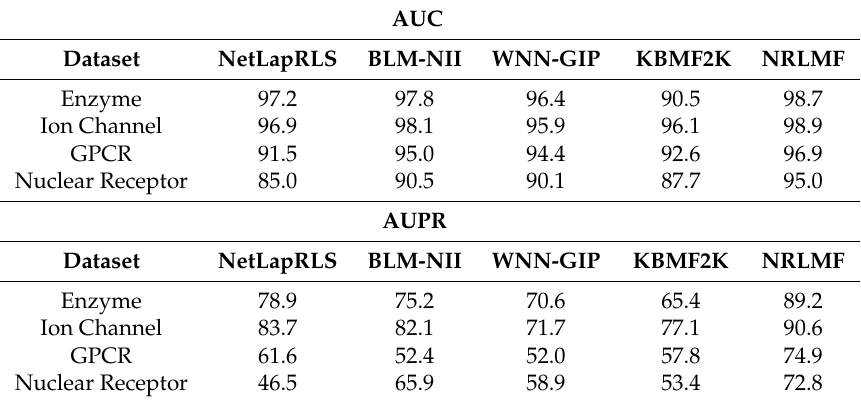
Table 3. Performance comparison of different types of prediction models